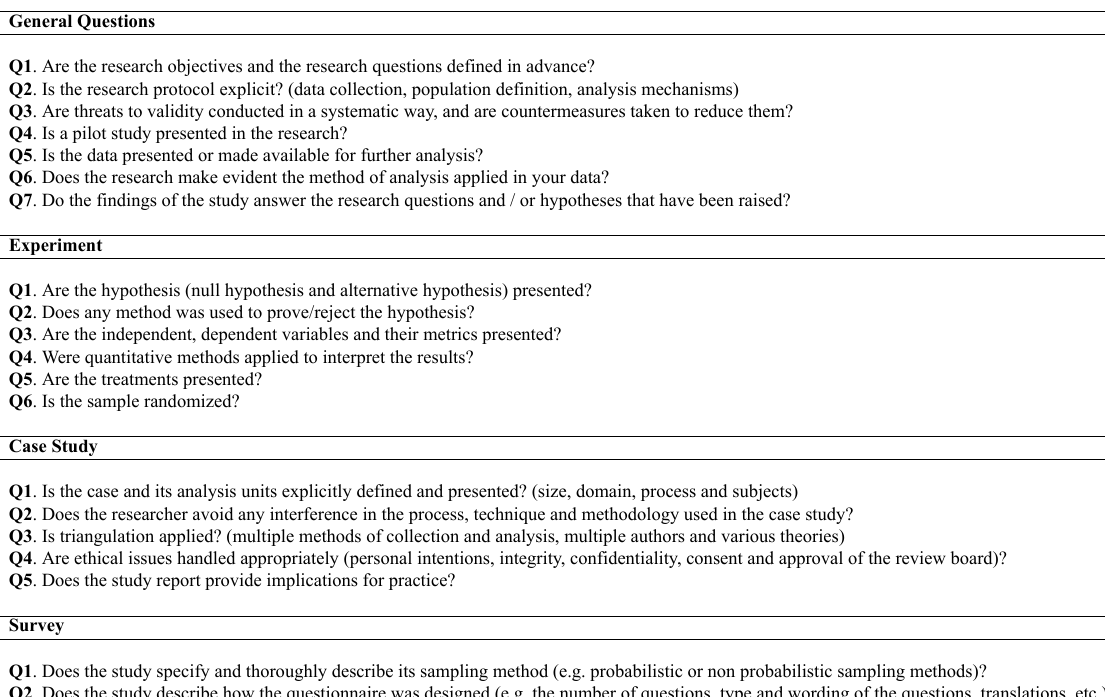
Figure 2. Classification and quality assessment process. Table 1. Checklists used to evaluate the studies.